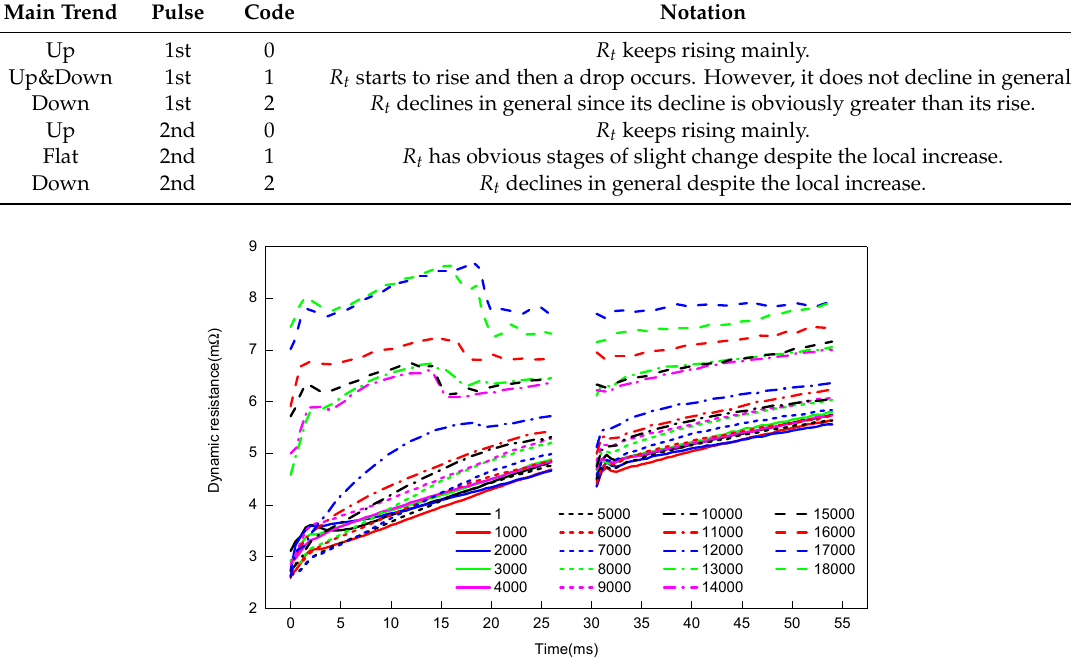
Figure 5. Change of dynamic resistance profile during the electrode life.